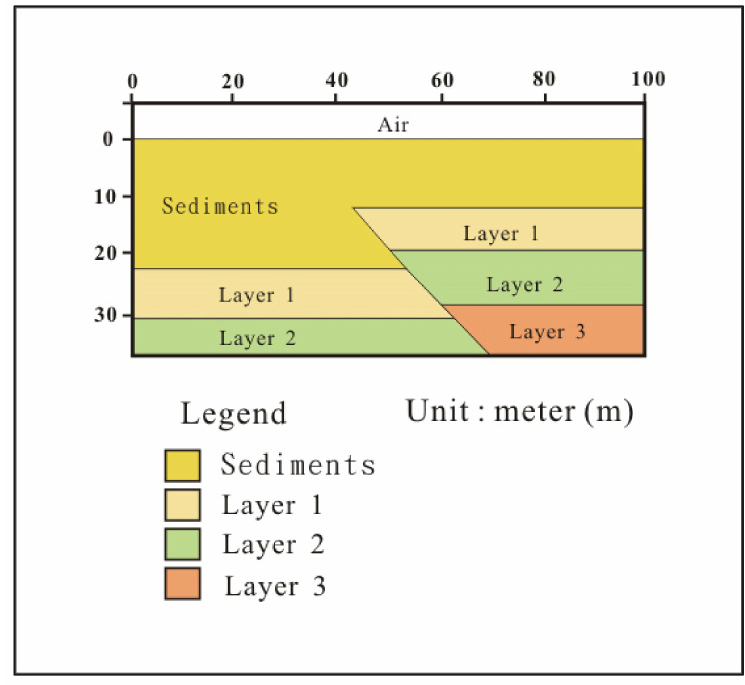
Figure 1. Hypothetical model of a thrust fault for the synthetic model